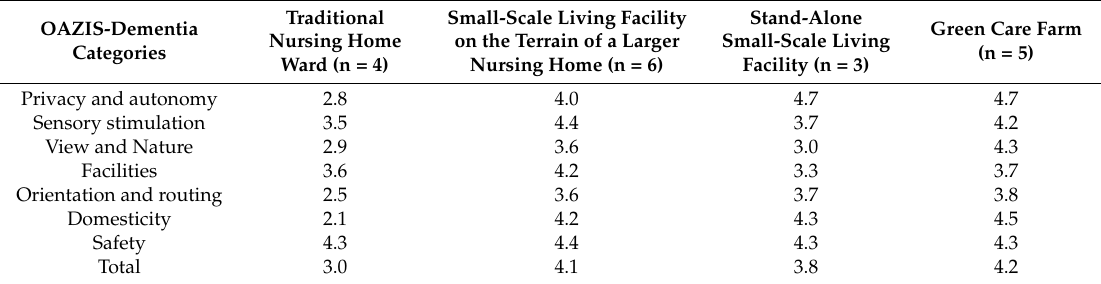
Table 4. Scores on the OAZIS-Dementia per type of nursing home.